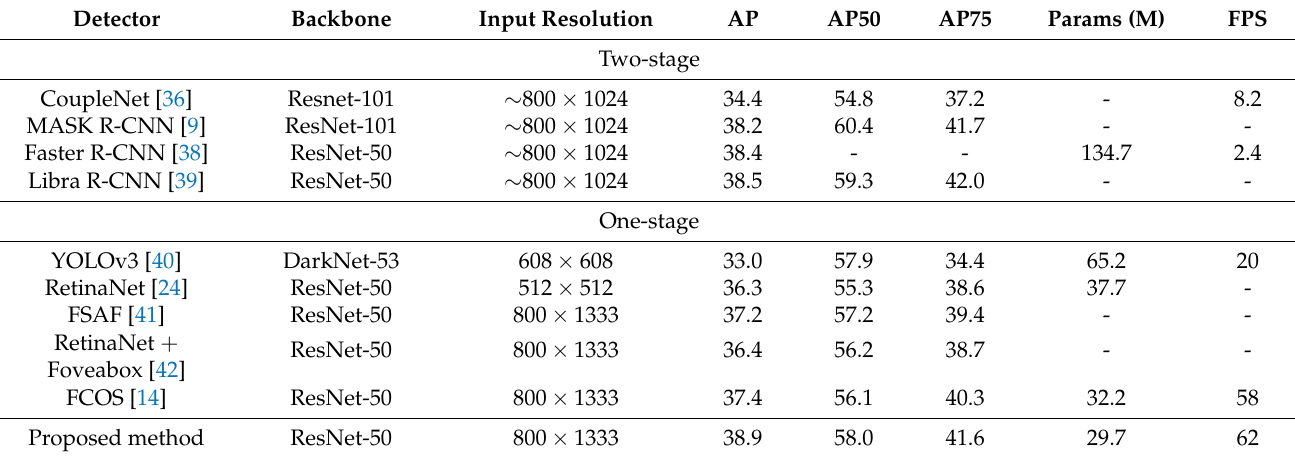
Table 4. Comparison of MS COCO2017 minval dataset detection